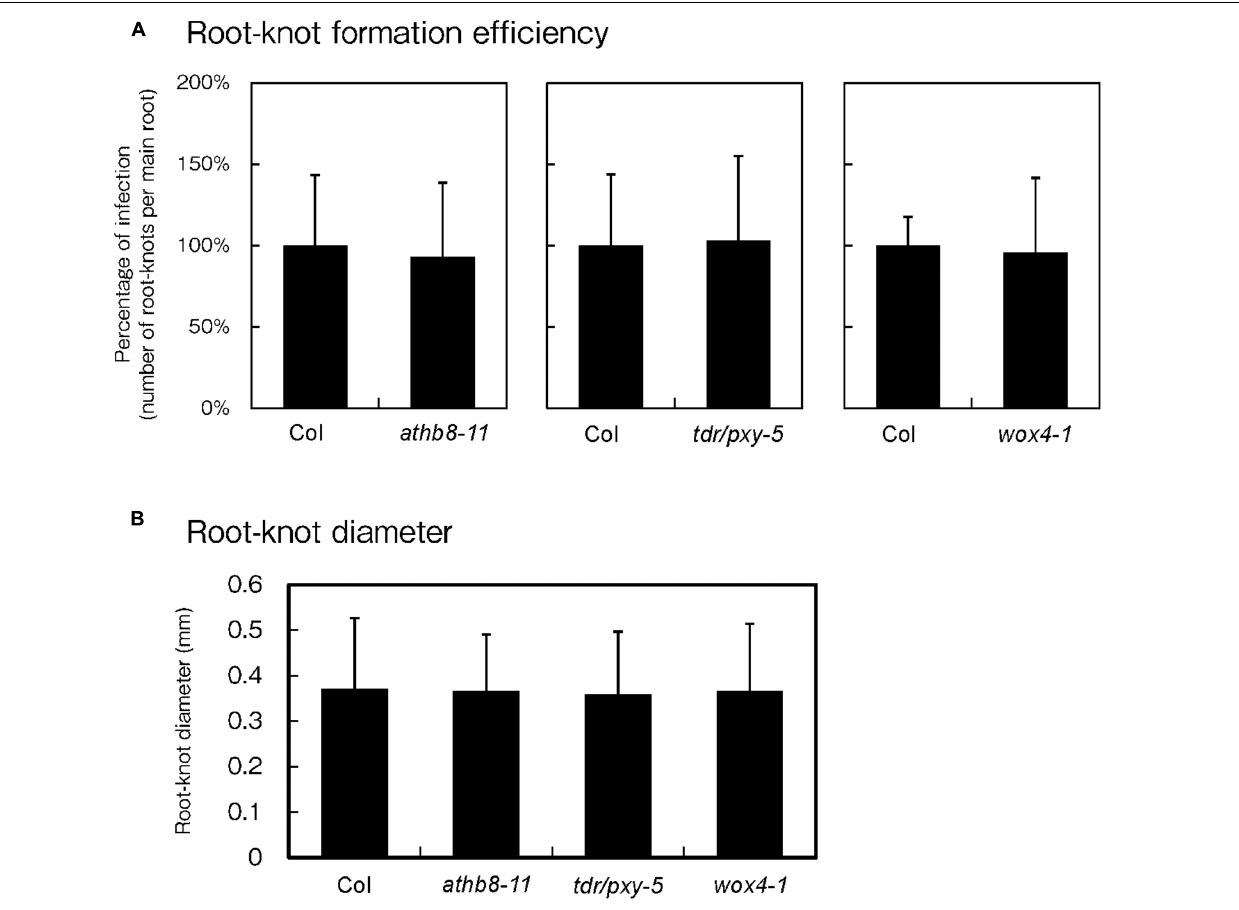
FIGURE 6 | Effect of mutations on procambium-associated genes during M. incognita infection. Quantitative analysis of the gall numbers at 14 dpi (A) and gall diameters at 7 dpi (B) . Note that the comparison of gall numbers between the wild-type and the mutants was performed independently. The means of the percentages of infection from the mutant lines respect to the wild type controls are shown ±